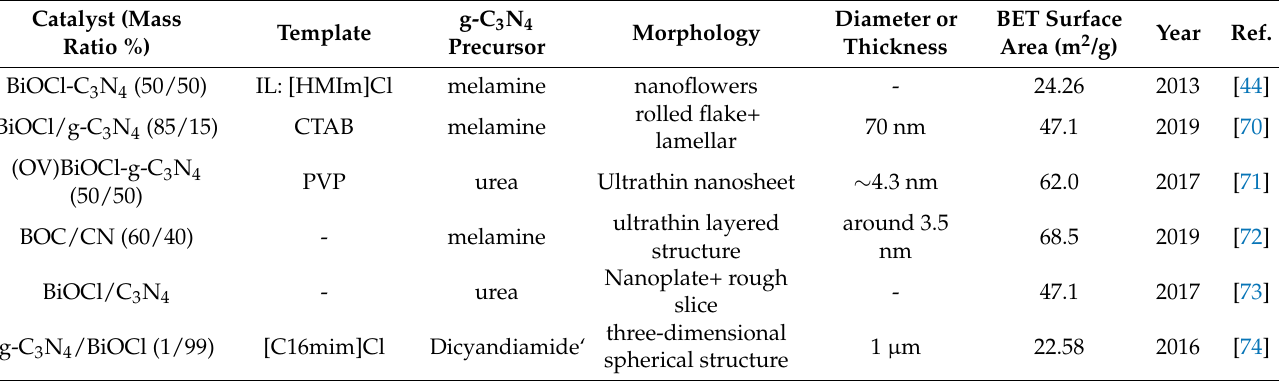
Figure 2. SEM images of ( a ) flower-like BiOCl and ( b ) g-C 3 N 4 /BiOCl. Reproduced with permission from Hou W et al, ChemistrySelect; published by John Wiley and Sons, 2020. Table 3. G-C 3 N 4 /BiOCl heterojunctions synthesized by solvent thermal